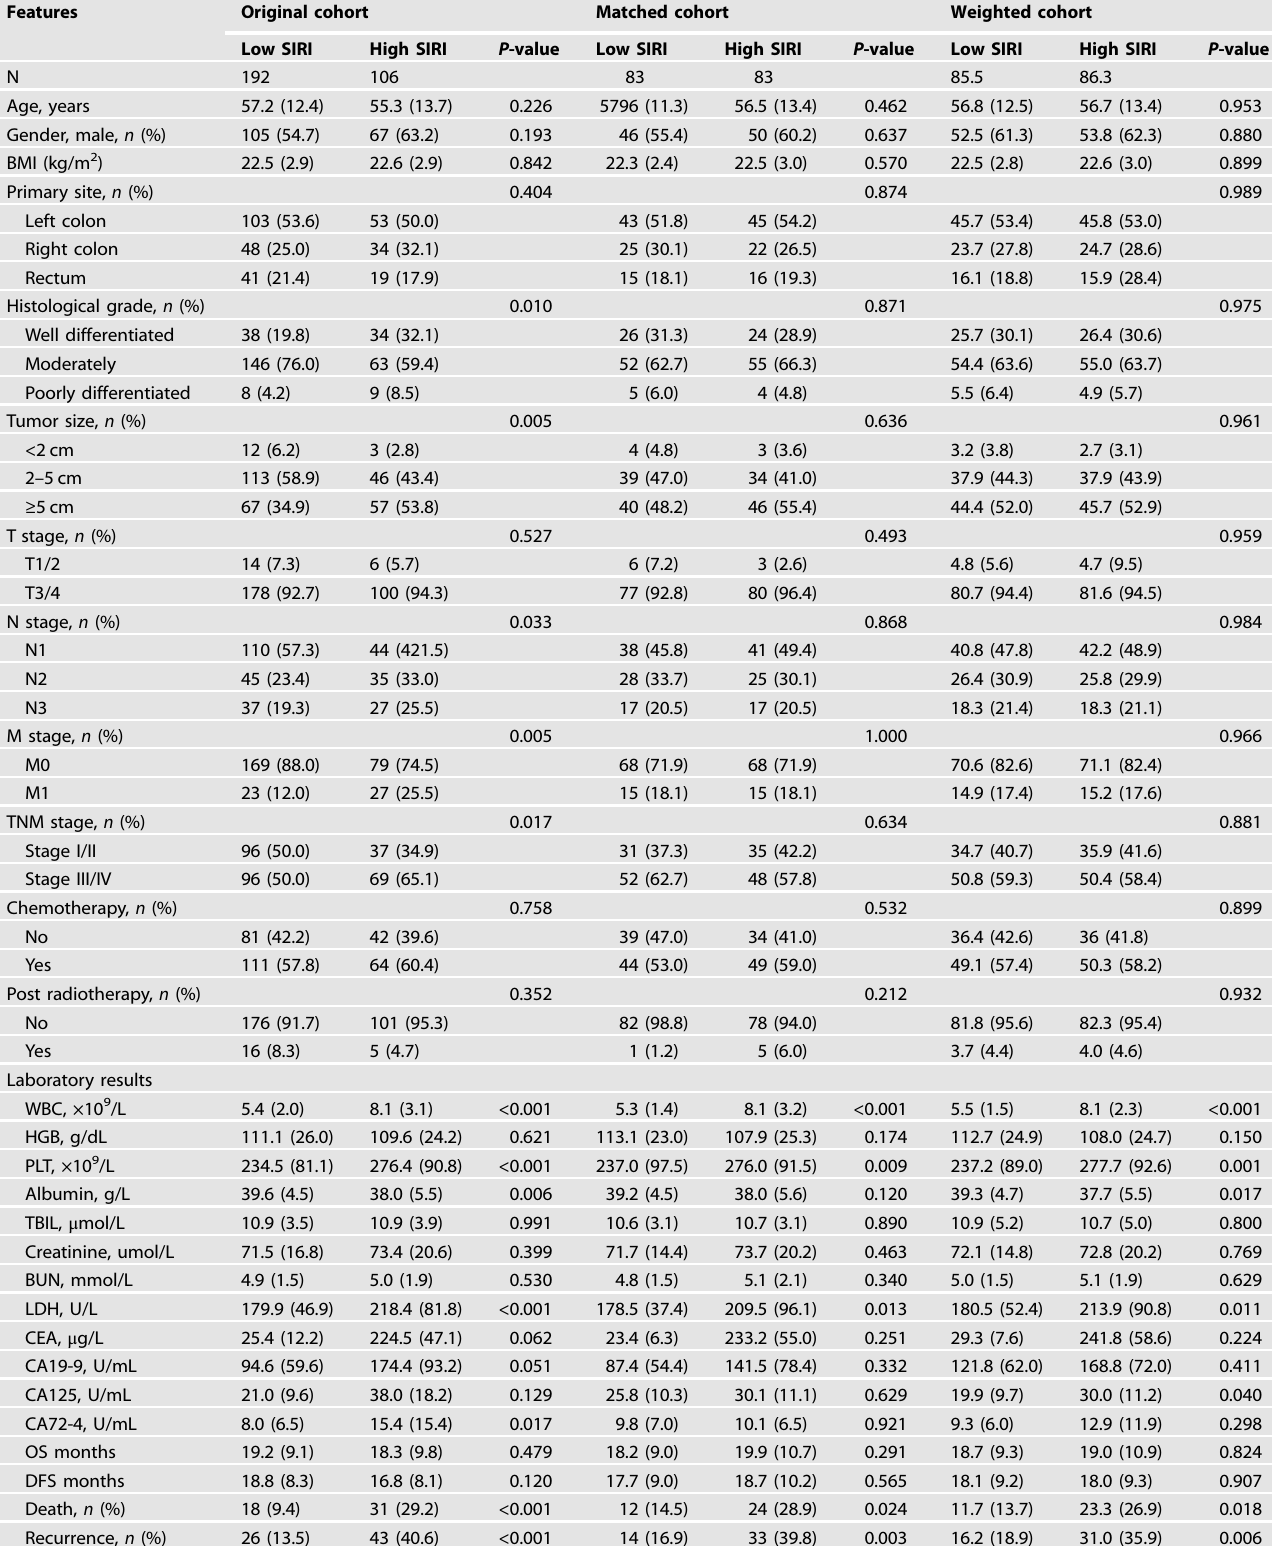
Table 1. Comparisons of clinical characteristics between low SIRI and high SIRI groups in the original, matched and weighted cohorts.